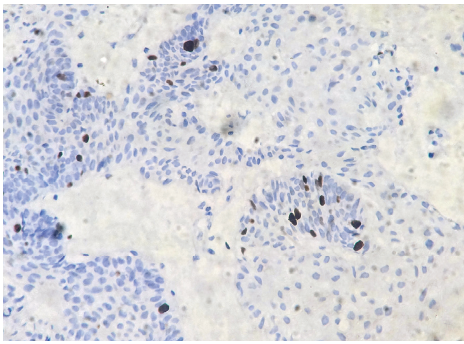
Figure 7: Photomicrograph showing sheets of odontogenic epi- thelial follicles lined by tall columnar cells enclosing stellate re- ticulum-like cells within the connective tissue stroma (H&E 4x view).